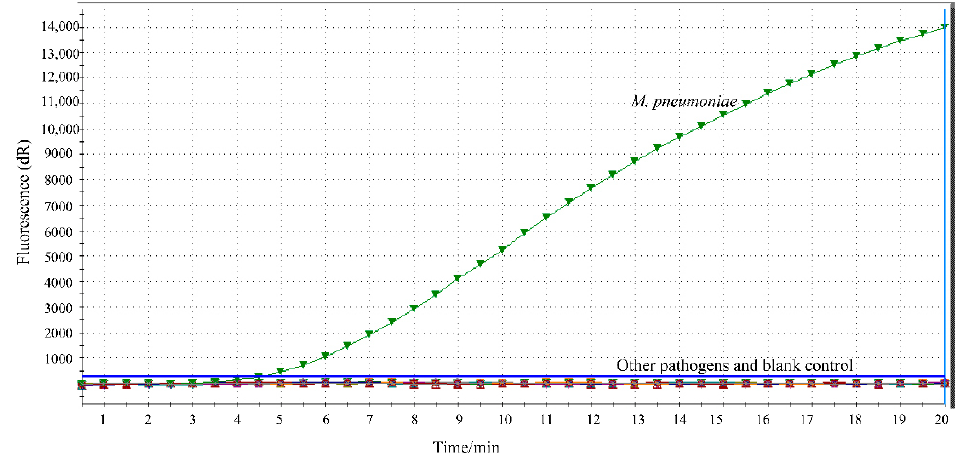
Figure 2. Analytical specificity of the RPA assay. The specific fluorescence signal was observed from M. pneumoniae and no signals were obtained from other pathogens (19) and blank control.